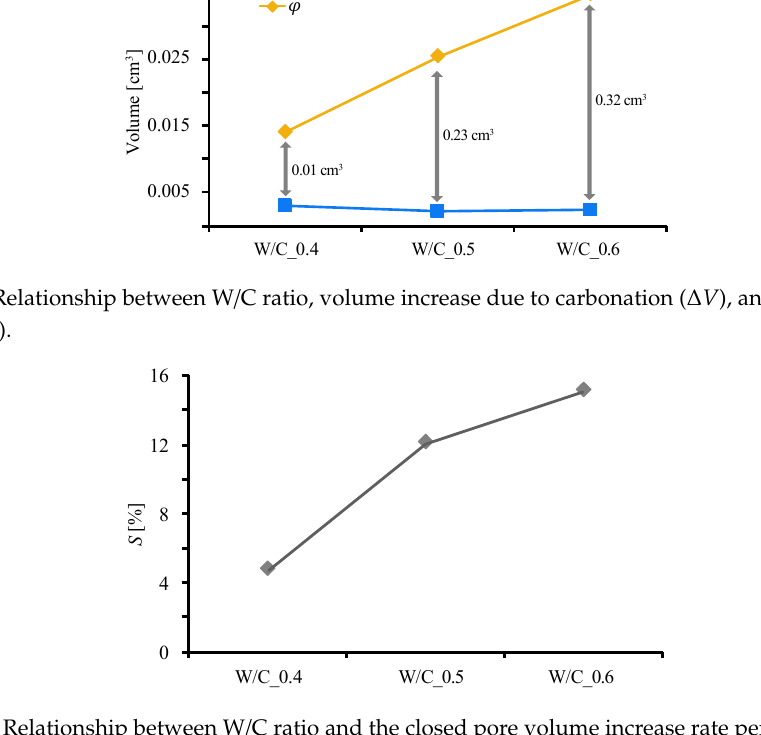
Figure 10. Relationship between W / C ratio and the closed pore volume increase rate per unit volume increase due to the generation of CaCO 3 ( 𝑆 ).